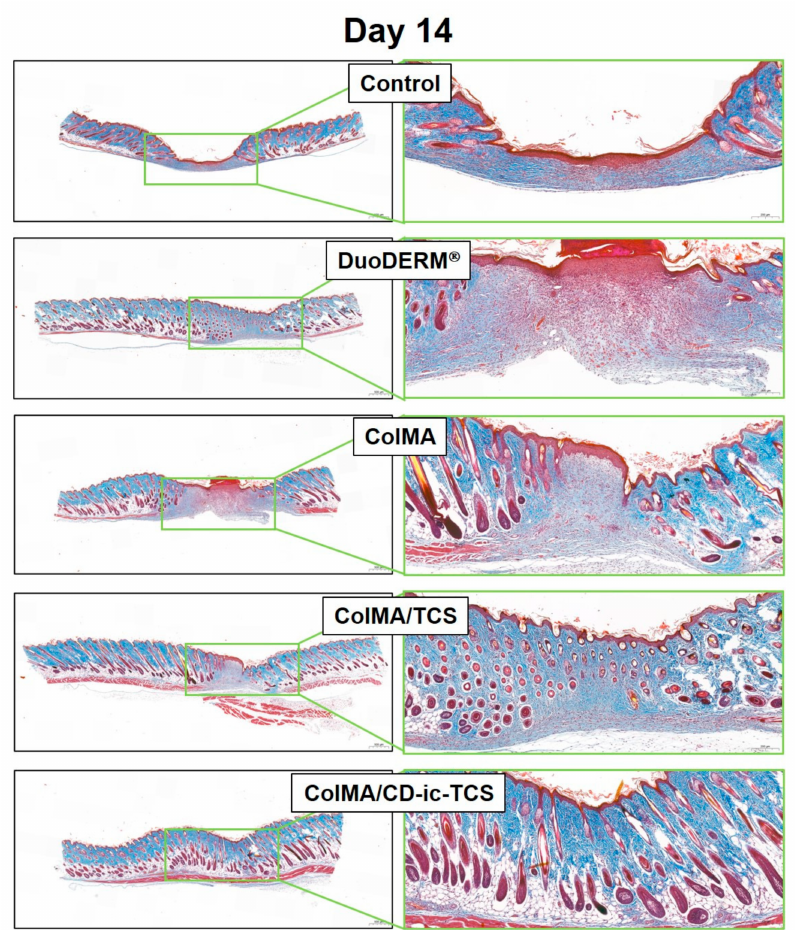
Figure 10. MT-stained slides of wound defects treated with DuoDERM ® , ColMA, ColMA/TCS, or ColMA/CD-ic-TCS for 1, 7, and 14 days. The left and right images were observed at 2.0 × (500 µ m) and 7.0 × (200 µ m), respectively. ColMA/TCS—triclosan (TCS) incorporated ColMA; ColMA/CD-ic- TCS—HP- β -CD/TCS complex incorporated ColMA. Blue color indicates